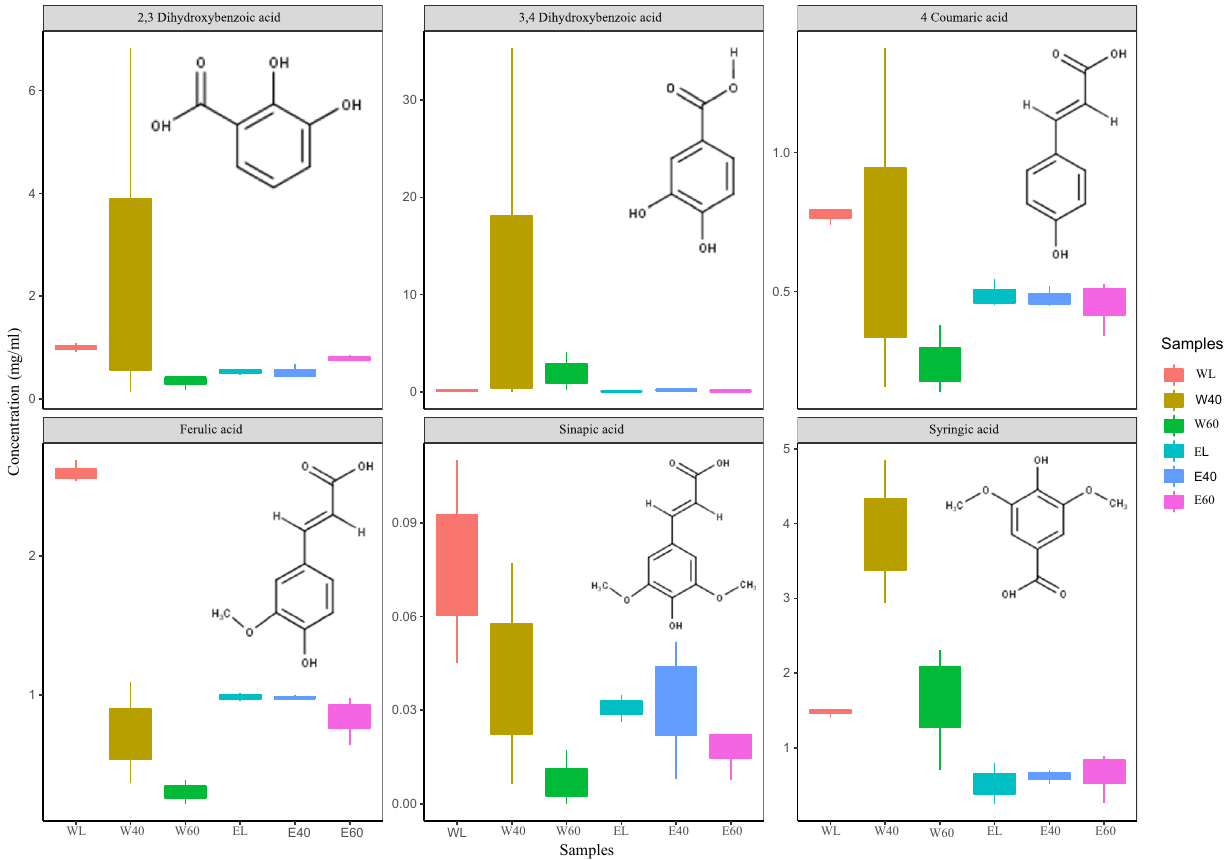
Figure 4. Semi-quantification of phenolic acids in A. macrostachyum water and 50% EtOH extracts. Figures displaying semi-quantification were developed using R 3.6.3 (https:// www. rstud io. com/ produ cts/ rpack ages/) and ggplot2 package (https:// ggplo t2. tidyv erse. org). Chemical structures depicted were drawn using Marvin 20.21.0 (https:// www. chema xon.